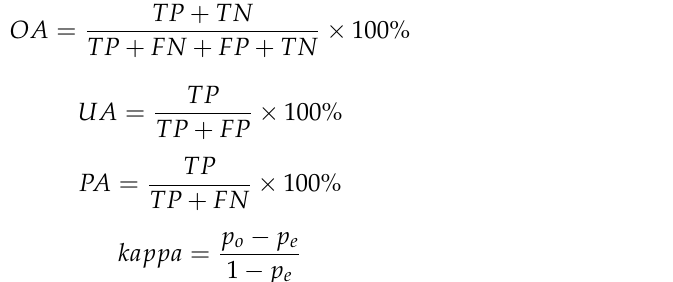
Figure 12. UA (user’s accuracy) bar chart of seven algorithm calculated from confusion matrix. 3.2. Classification Results of Different Sample Point Densities For different sample point densities, the overall accuracy trends of the corresponding classification with the number of sampling points are shown in Figure 13. It can be seen